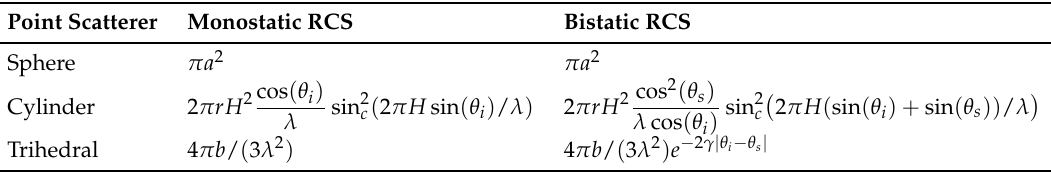
Table 3. Monostatic and bistatic RCS for three kinds of scatterer: θ i and θ s are the incident and scattering angles (with regard to the horizontal plane), a is the sphere radius, r and H are the cylinder radius and height, b is the trihedral side length, and γ = 0.146 see [58]. Point Scatterer Monostatic RCS Bistatic